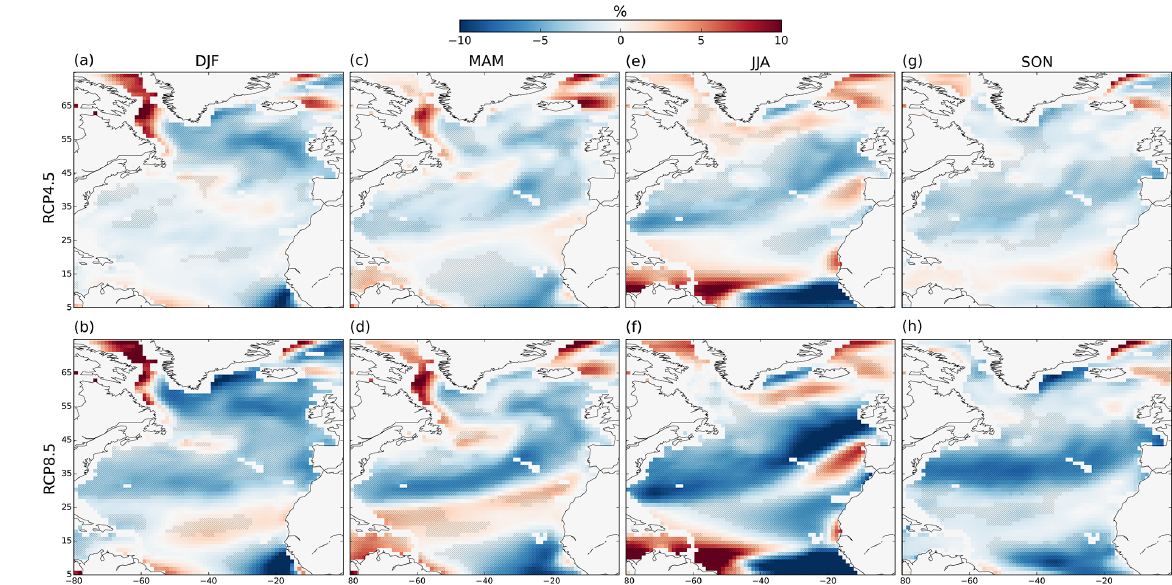
Figure 3. EC-Earth projected changes (%) in 10m wind speed over the North Atlantic Ocean for the period 2070–2099 relative to 1980– 2009. Ensemble mean for RCP4.5: (a) DJF (c) MAM (e) JJA (g) SON. Ensemble mean for RCP8.5: (b) DJF (d) MAM (f) JJA (h) SON. Hatching covers areas where the changes are greater than twice the inter-ensemble standard deviation of the past period